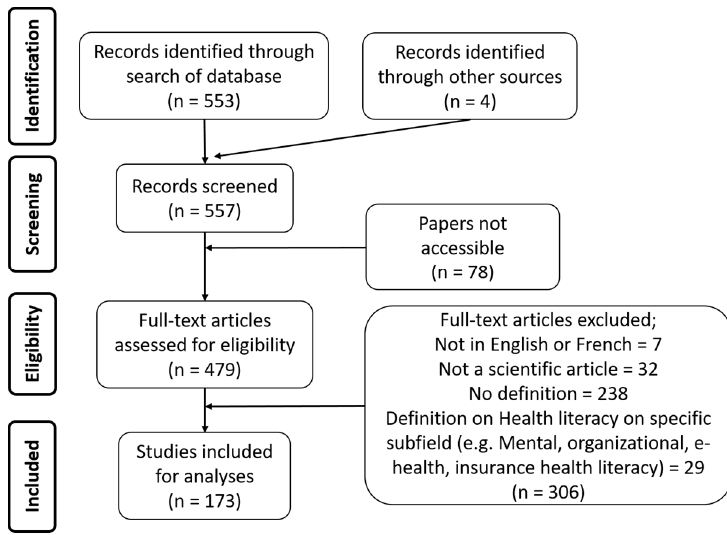
Figure 1. Prisma flow chart.